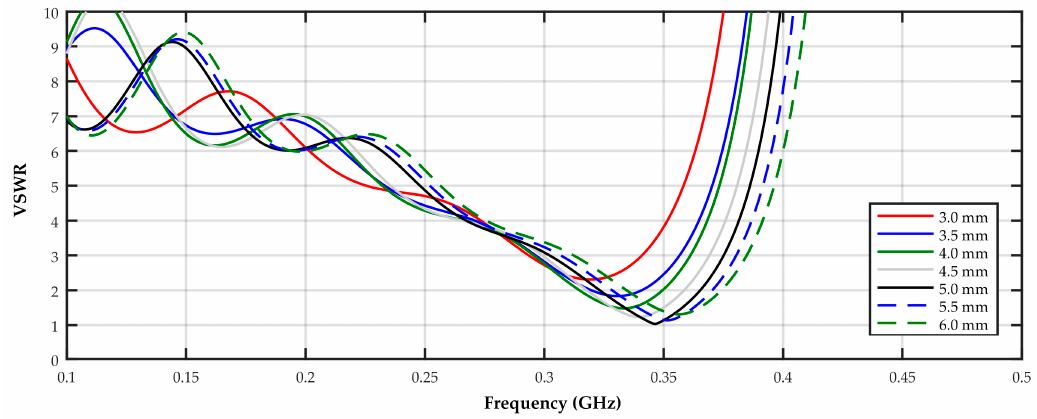
Figure 6. Simulated VSWR for meandered PIFA with various loading chip resistors and constant H = 5.0 mm.